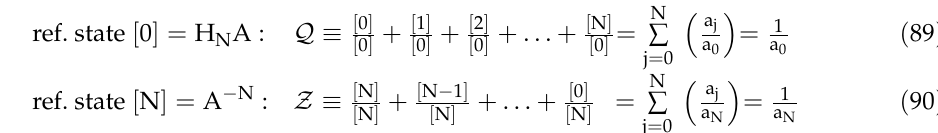
Figure 22. Ionization fractions a j (dashed curves) and probability density functions f 0 and f N .